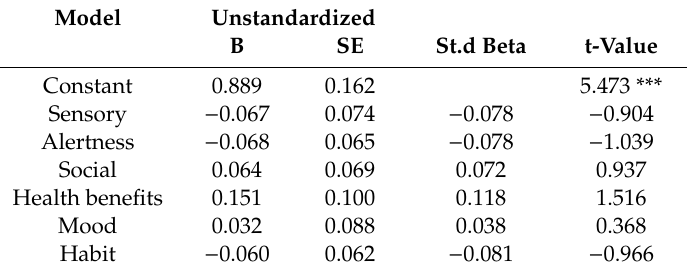
Table 9. Results of regression analysis of motivations that influence the consumption of soft drinks and others